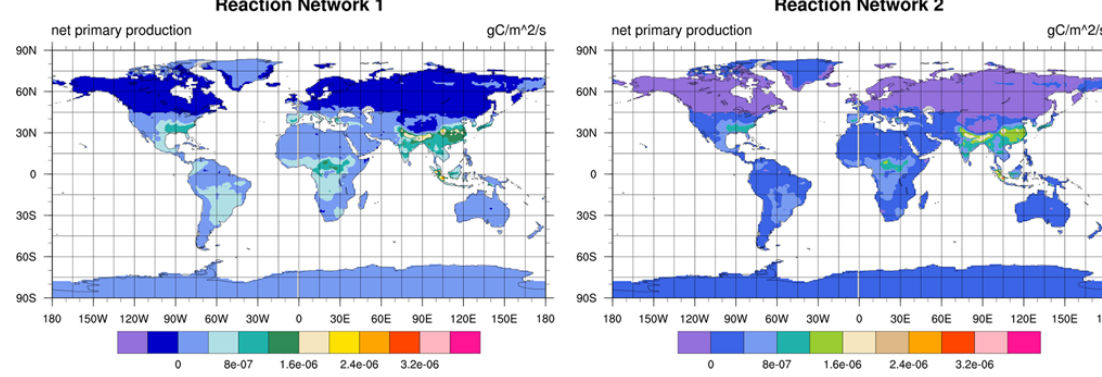
Fig. 4. NPP distribution using Reaction Network 1 (left) and Reaction Network 2 (right).